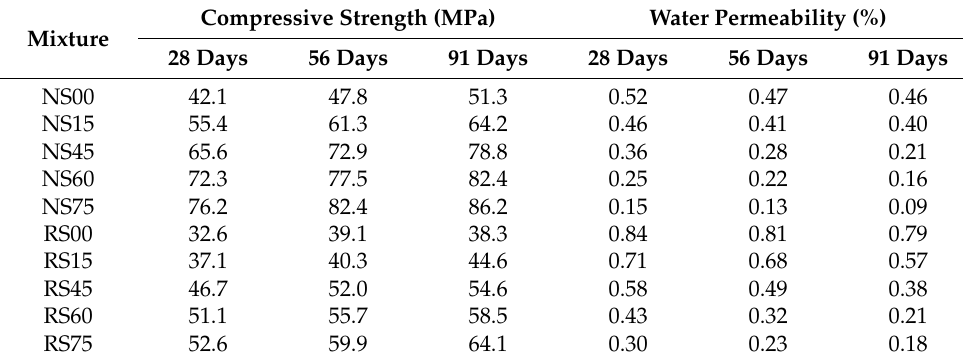
Table 7. Results of the concrete water permeability measurements.